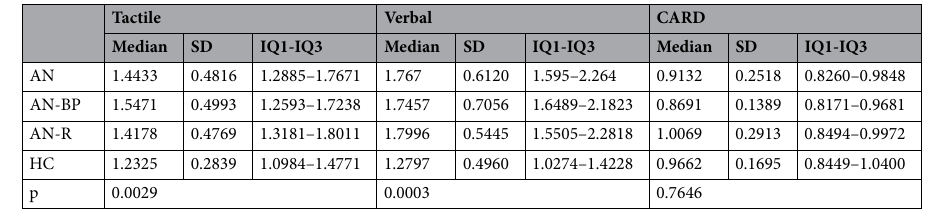
Table 2. Tactile and verbal ratio for AN and HC. Wilcoxon signed-rank test between AN and